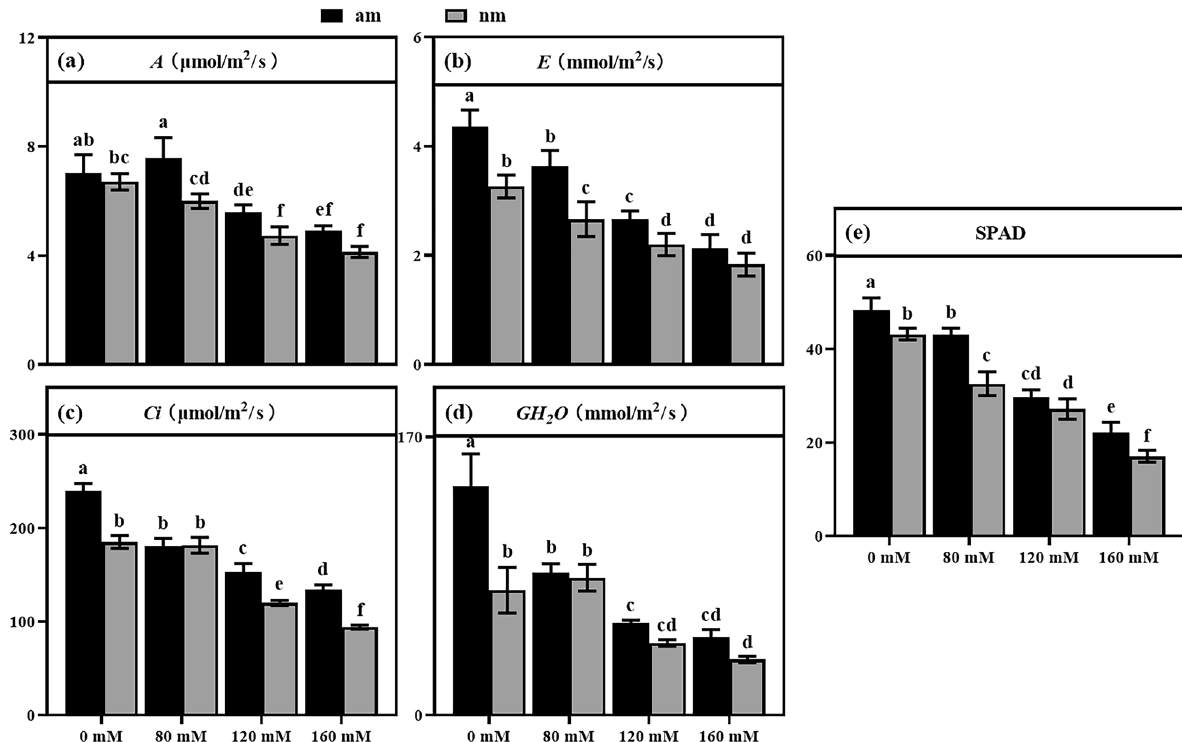
Fig. 2 Photosynthetic gas exchange parameters and SPAD value of rice leaves between different treatment groups. Note: a A ; b E ; c Ci ; d GH 2 O ; e SPAD. The results are presented as the mean standard deviation of three replicates. Different letters indicate the difference between different ± treatment groups ( P <